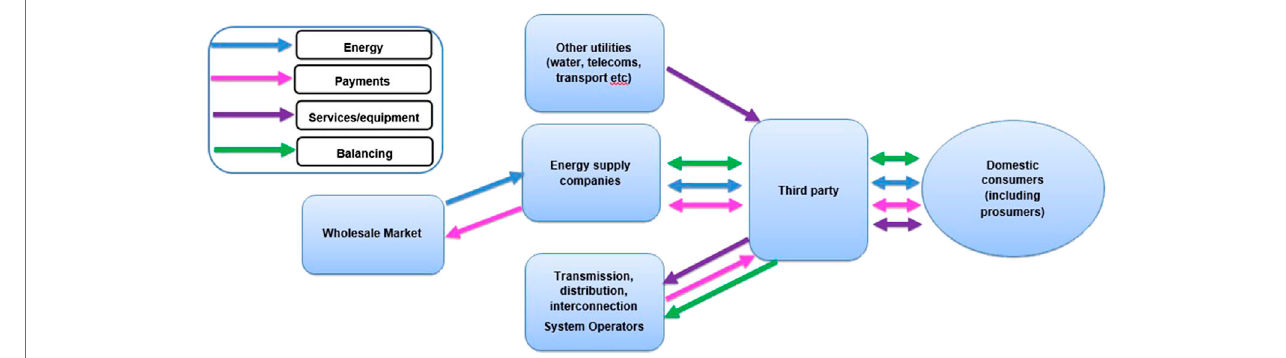
FIGURE 1 | Third party control business model